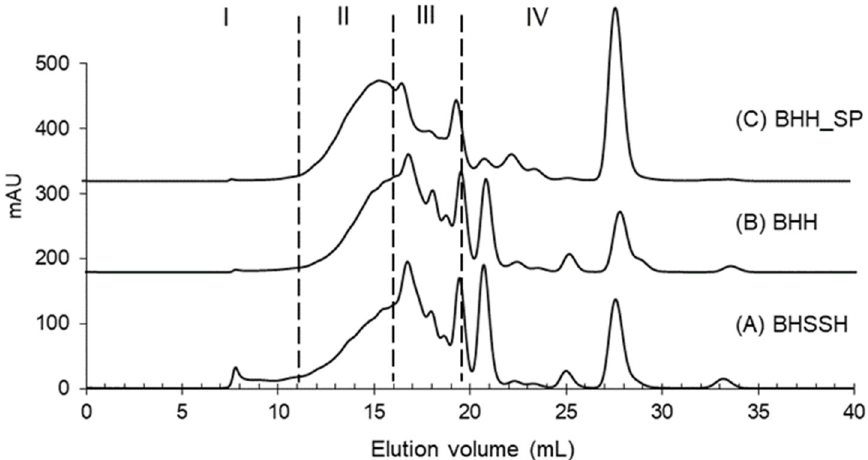
Figure 1. Size exclusion chromatograms of Baltic herring hydrolysates. A = Baltic herring side stream hydrolysate (BHSSH); B = Baltic herring hydrolysate (BHH); and C = Sep-Pak purified Baltic herring hydrolysate (BHH_SP). The molecular weight distribution was divided into four ranges I: >10,000 Da; II: 10,000–1000 Da; III: 1000–200 Da; and IV: <200 Da. Table 2. Proportion (%) of molecular weight distributions of Baltic herring hydrolysates.